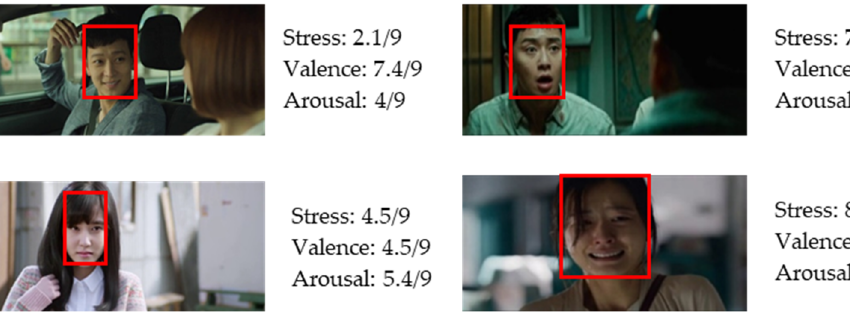
Figure 3. Frame examples in the SADVAW Dataset.